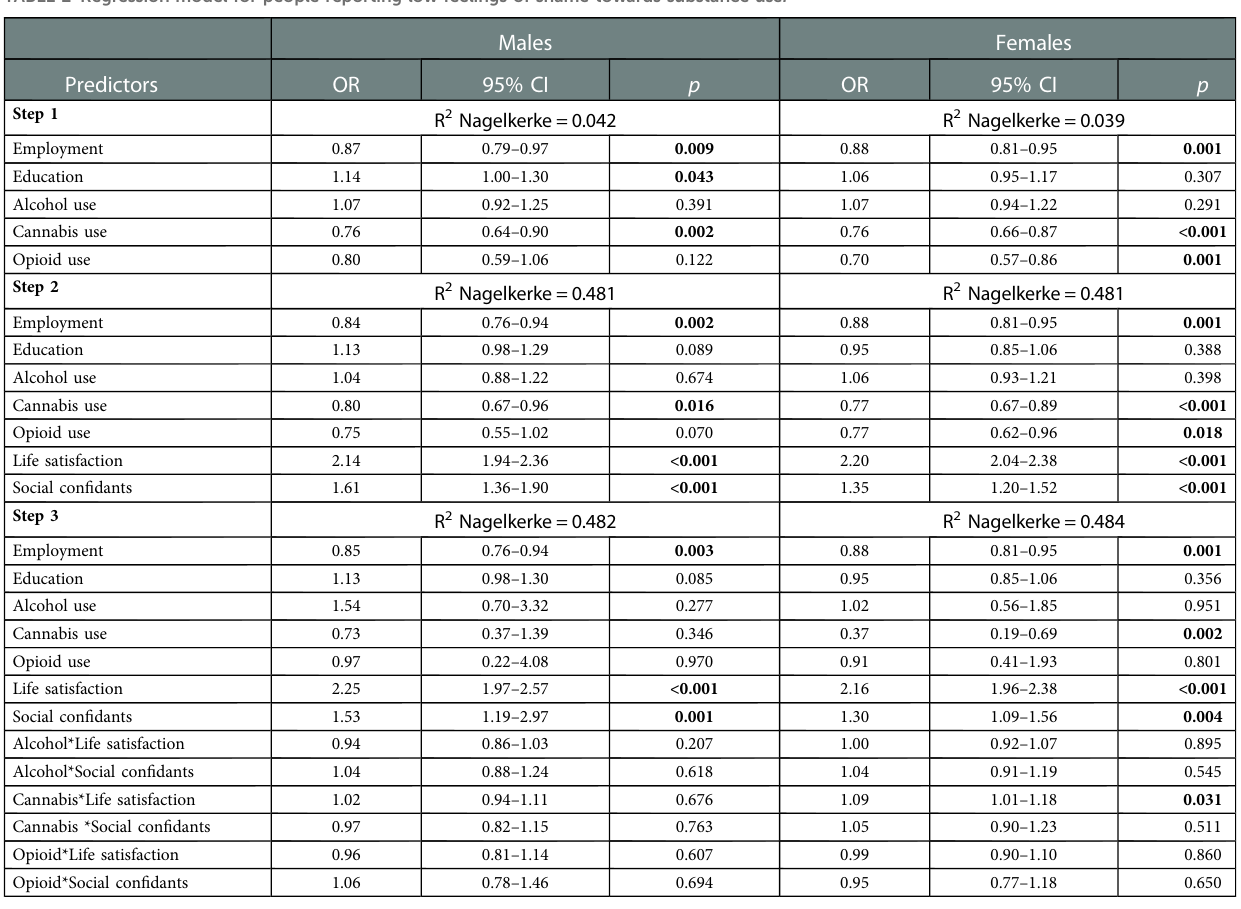
TABLE 2 Regression model for people reporting low feelings of shame towards substance us e.